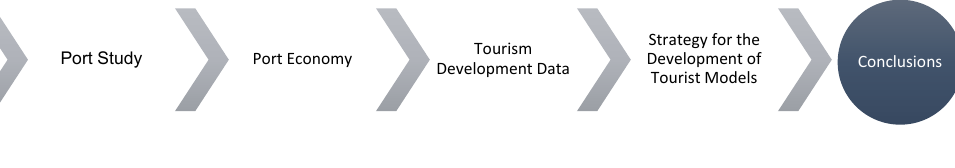
Figure 2. Organogram of the adopted methodology (source: Authors).